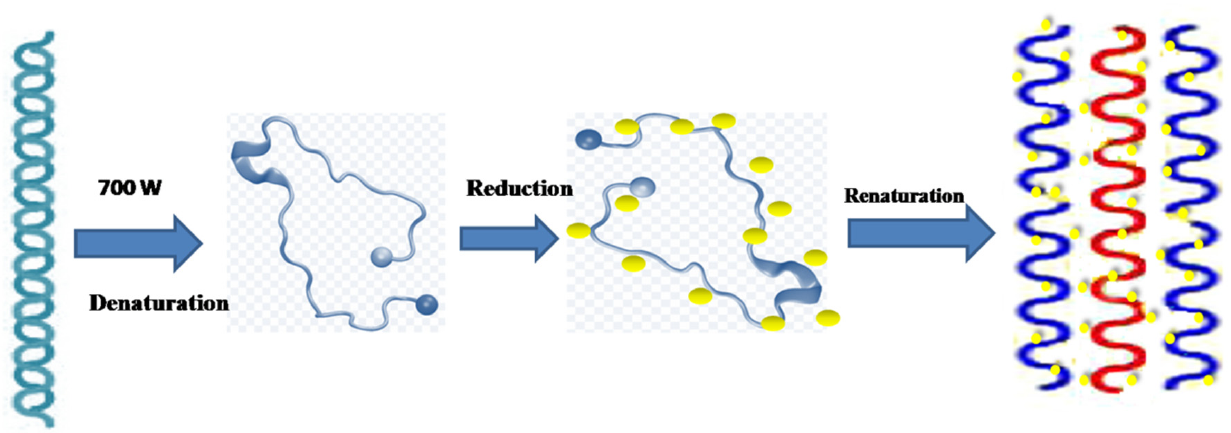
Figure 6. The scheme of synthesis and dispersion of fresh-prepared AgNPs.